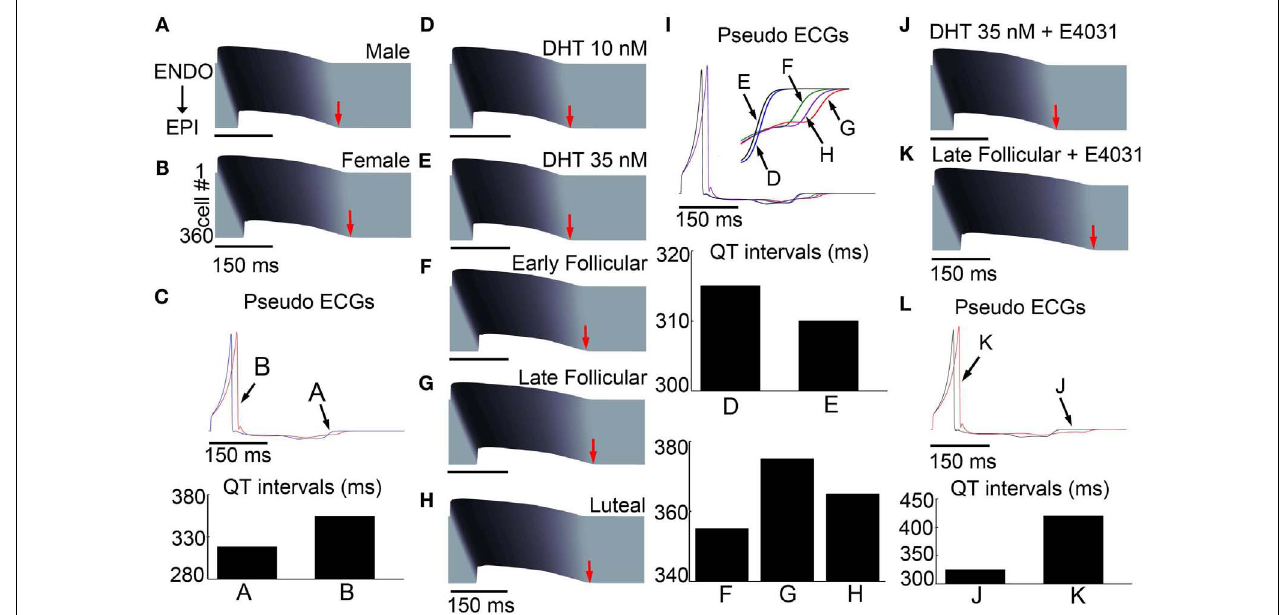
progesterone during the menstrual cycle and DHT on APs. (I) The virtual ECGs (the 500th beat) show QT intervals change during the menstrual cycle and two physiological concentrations of DHT, indicated by black arrows. (J,K) Disparate responses to I Kr channel block in the late follicular phase versus with DHT. (L) The computed ECG (the 500th beat) shows that QT interval is substantially longer in the late follicular phase [ (K) – red) than with DHT [ (J) – black]. Ninety five percentage repolarization of last cells indicated red